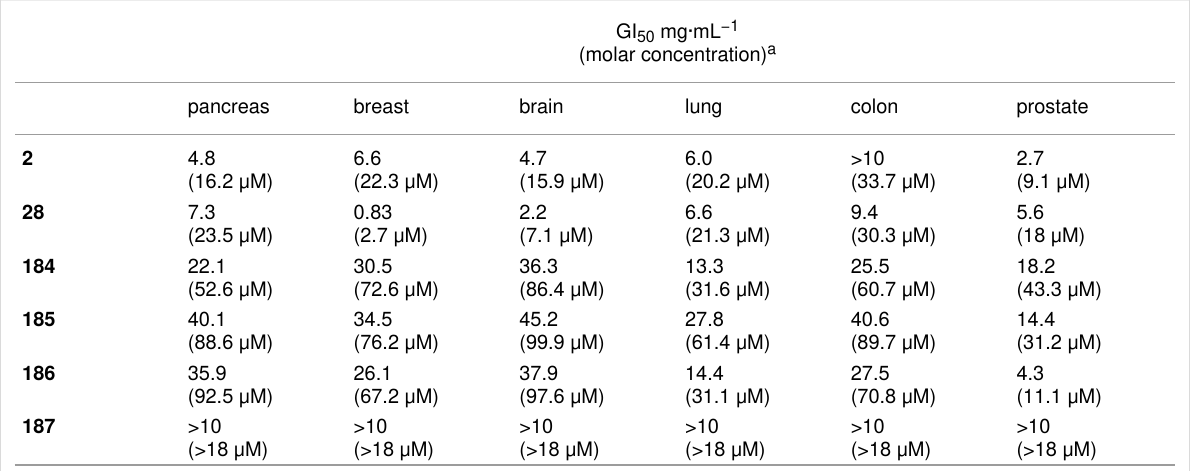
Table 4: Inhibition of cancer cell growth by combretastatin D-2 ( 2 ) and prodrug salts [55].